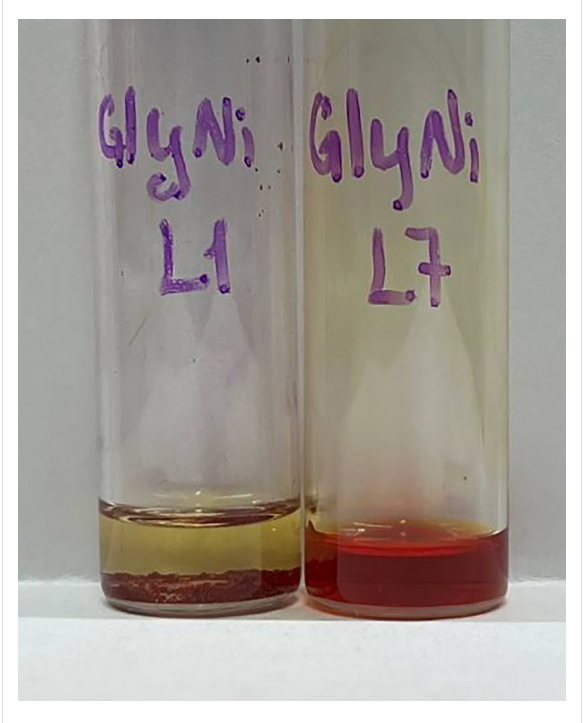
Figure 3: Saturated solutions of ( GlyNi ) L1 (left) and ( GlyNi ) L7 (right) in diethyl